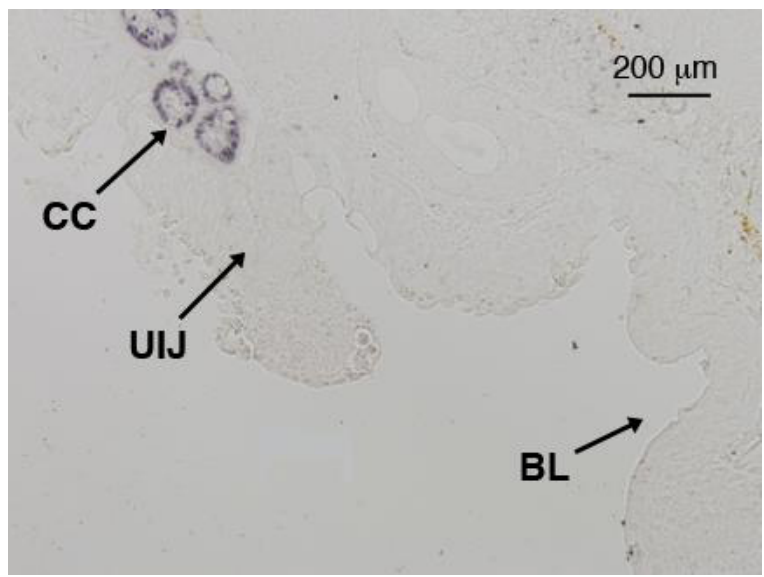
FIGURE 2 . Ki-67–stained section of the ICP bladder demonstrating sparse Ki-67 staining of the urothelium at the urointestinal junction (UIJ) and bladder (BL). Intestinal crypt cells (CC) stain positively for